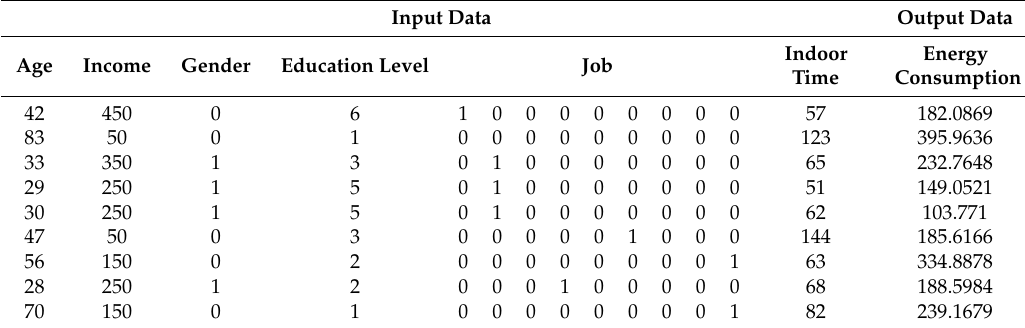
Table 8. Sample of data